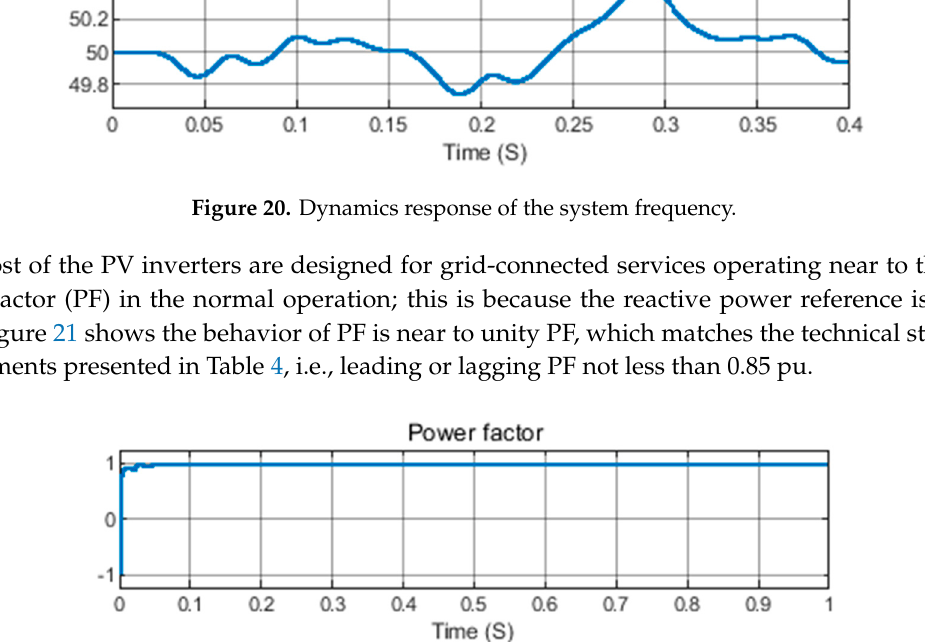
fluctuation performance for the proposed large-scale GCPS operating at 50 Hz, the symmetrical three-